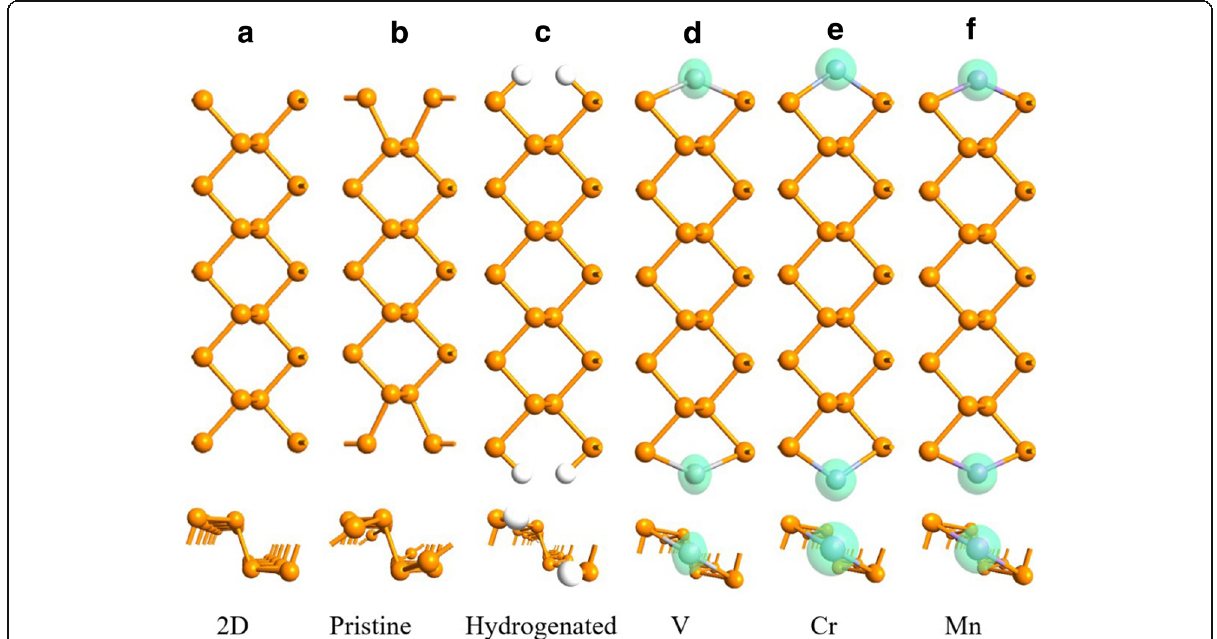
Fig. 2 Geometries of FM 9-APNRs a just cut from a 2D phosphorene, b geometrically optimized (pristine), c hydrogenated, and after adsorbing d V, e Cr, and f Mn atoms on edge. The density of spin polarization of the atoms is shown by the green isosurface at the value of 0.004 e/Å 3